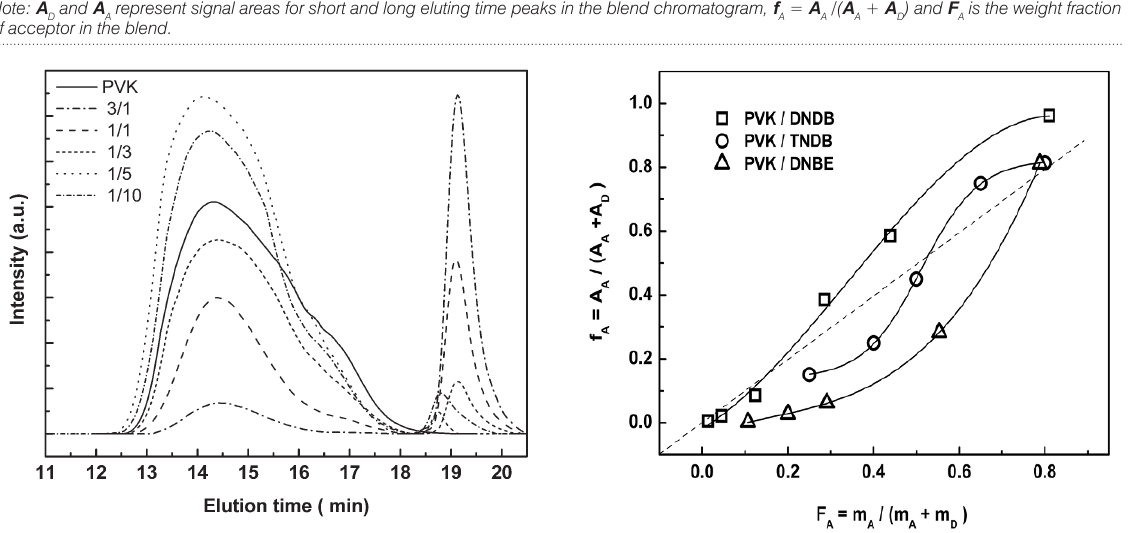
Figure 3. f = f(F ) plots for mixtures in A A